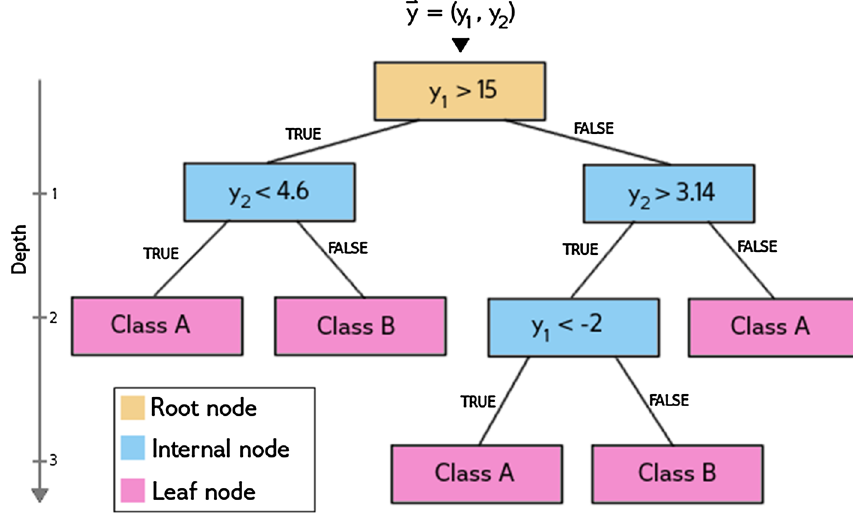
Fig. 1 Graphical representation of a sample decision